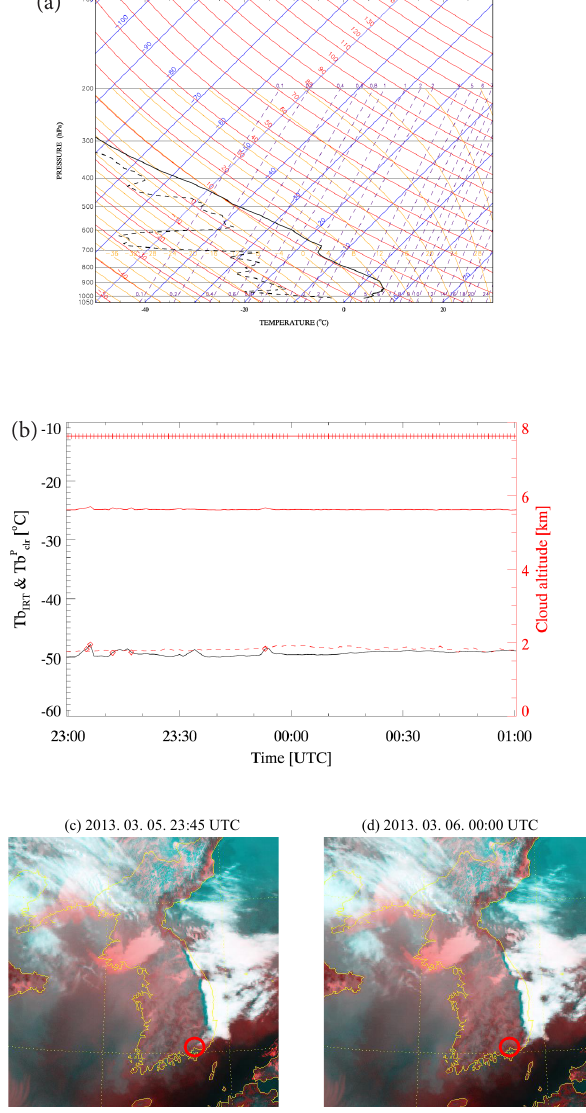
Figure 14. Vertical profiles of temperature (black solid line) and dew point temperature (black dashed line) on 6 March 2013 (a) showing a strong inversion layer from the ground to about 950hpa, time series of Tb IRT (black solid line), predicted clear-sky Tb (red dashed line), σ 1min (red solid line; for clarity, value − 25 ◦ C has been added to the original value), and cloud-base altitude ( + ; scale is on the right) from the ceilometer (b) , and color composite satel- lite images for 23:45UTC on 5 March 2013 (c) and 00:00UTC on 6 March 2013 (d) , showing passing of the cloud edge through the north of observation